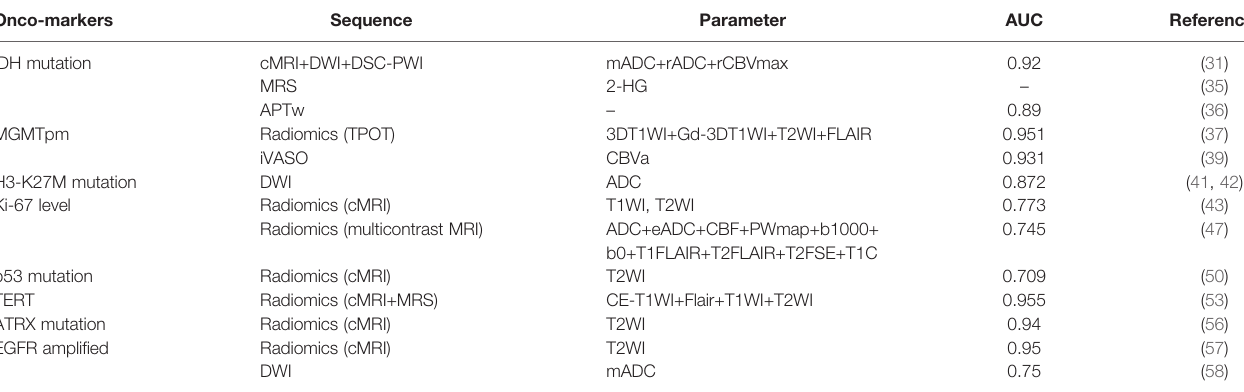
TABLE 2 | Detection of onco-markers preoperatively by MRI.